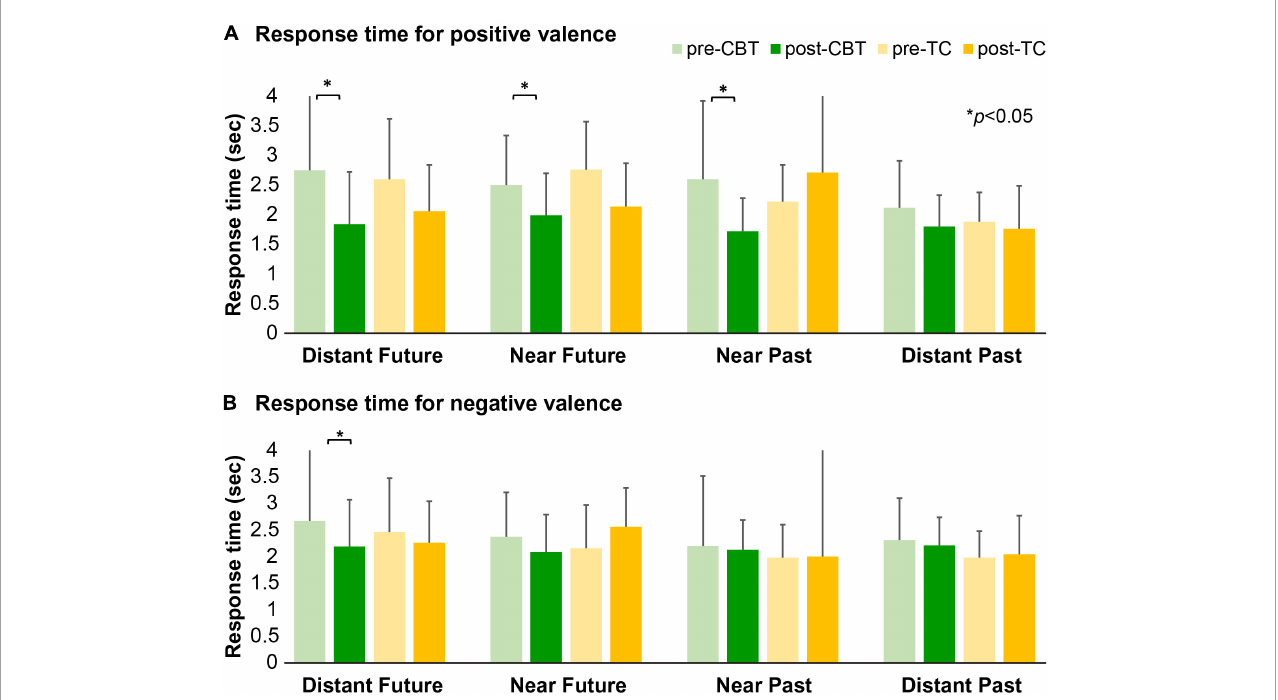
FIGURE3 The response time for the future thinking task. Mean RTs for positive (A) and negative valence (B) across the four different conditions for the CBT and TC groups before and after treatment. CBT, cognitive behavioral therapy; TC, talking control; RT, response time. (A) Greater reductions in RTs for both positive valence in the distant future condition ( p = 0.012), near future condition ( p = 0.017), and near past condition ( p = 0.02) in the CBT group. (B) A significant reduction in RT for negative valence in the distant future condition in the CBT group ( p = 0.03).